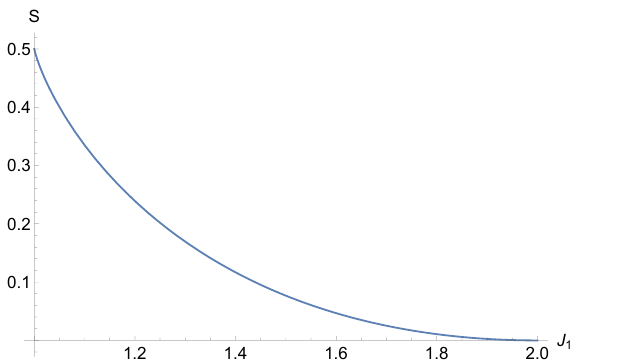
Figure 8 . Total action as a function of J 1 , in the special case of W = 0 from equation (3.13). J 1 and ∆ are related through equation